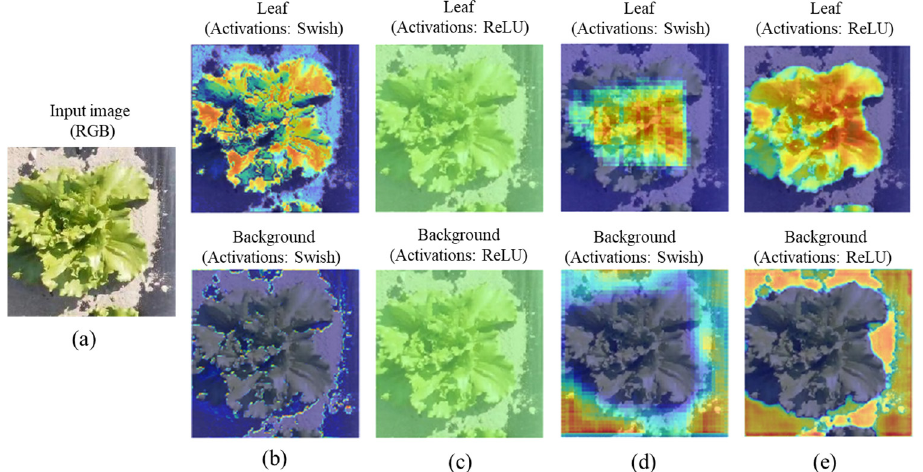
Figure 15. Visualization of the Grad-CAM in different depth of the network: ( a ) RGB image; ( b ) Grad-CAM visualization at shallow depth of the encoding layer; ( c ) Grad-CAM visualization at middle depth of the encoding layer; ( d ) Grad-CAM visualization at deep depth of the decoding layer; ( e ) Grad-CAM visualization at deep depth of the classification layer.